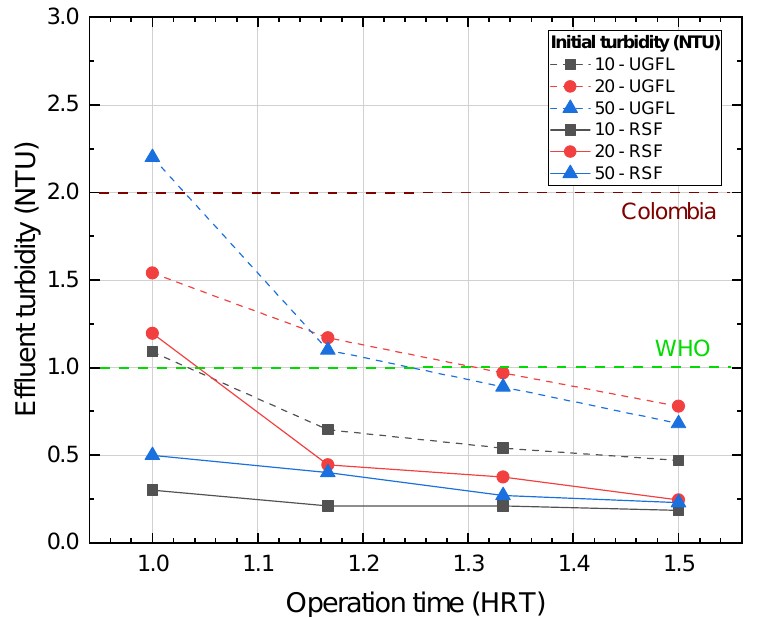
Figure 12. Results for the assessment of the increase in influent turbidity (PACl and 1.0 m 3